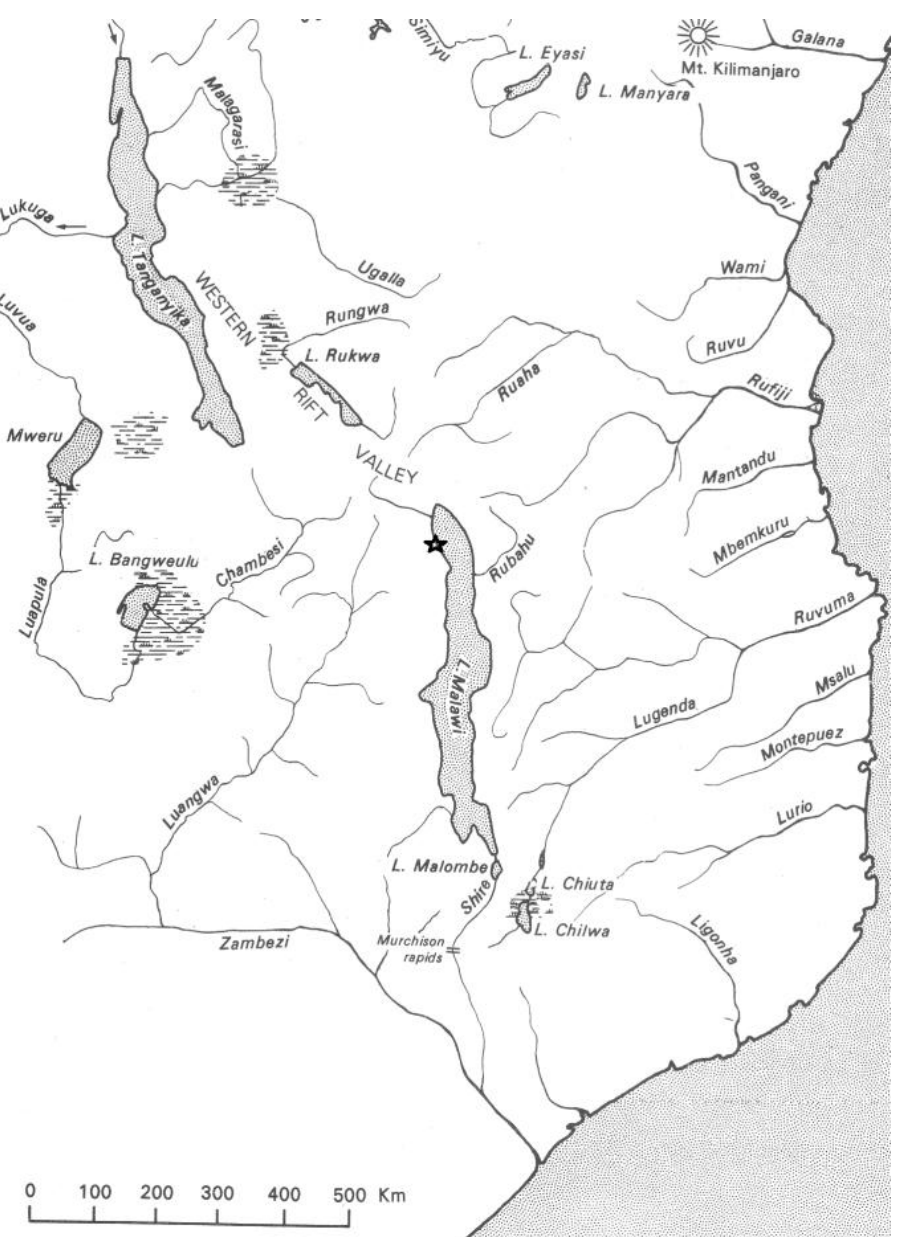
Fig. 3. Fig. 3. Modern Lake Malawi and Lake Tanganyika in the African Western Rift (after Beadle, 1974). The location of the fossiliferous Chiwondo Beds is indicated by a